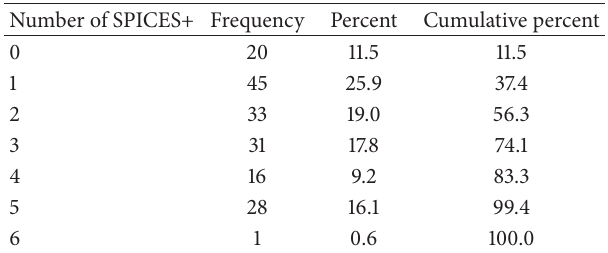
Table 2: Distribution of total SPICES identified for patients ( N =